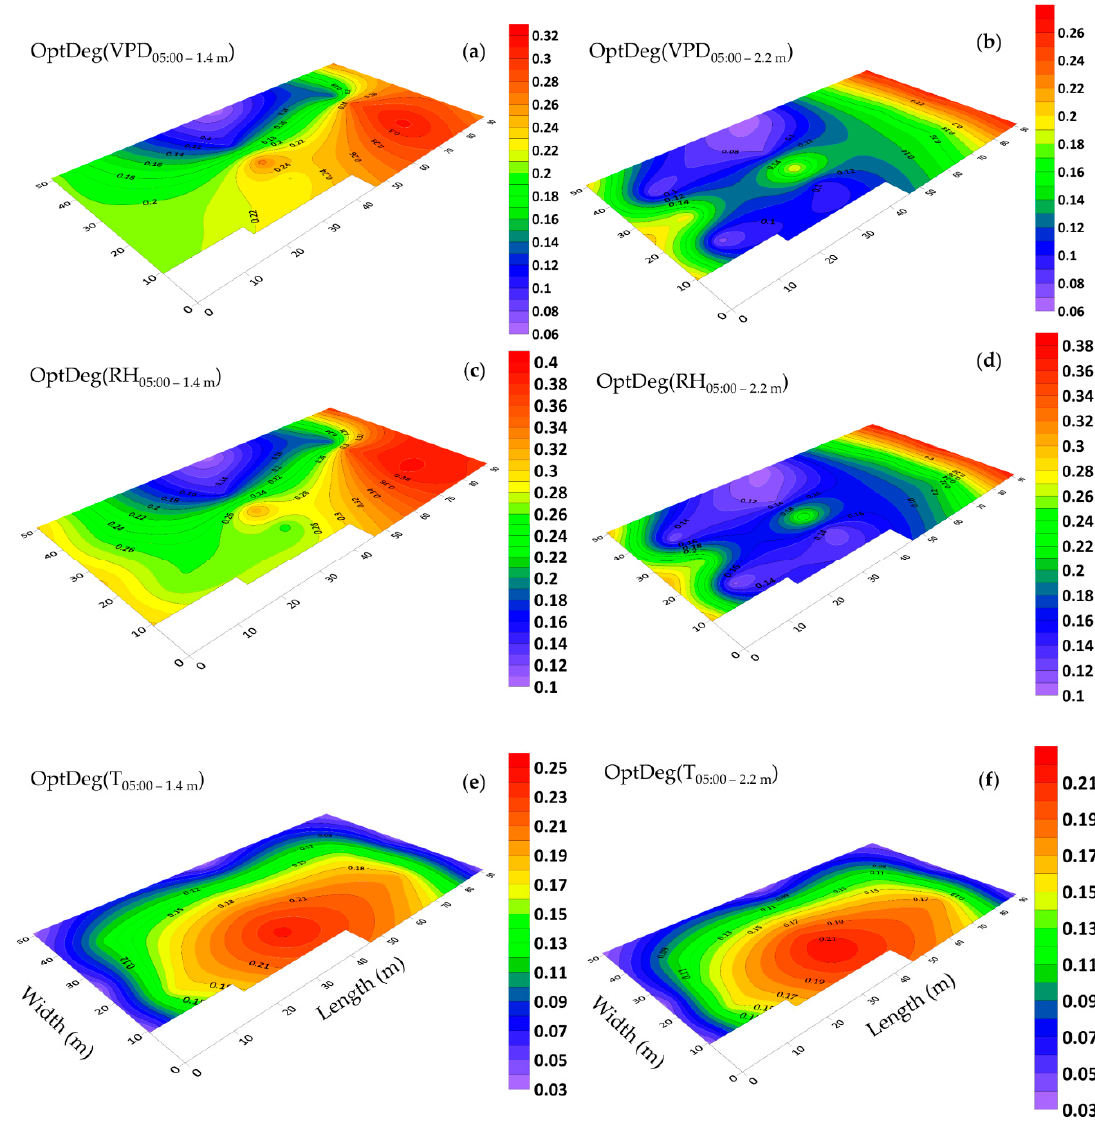
Figure 15. Optimality degrees range and distribution on a horizontal plane at 05:00 in 1.4 m and 2.2 m elevations on 10 June 2018. OptDeg(VPD) at 1.4 m ( a ) and 2.2 m ( b ); OptDeg(RH) at 1.4 m ( c ) and 2.2 m ( d ); and, OptDeg(T) at 1.4 m ( e ) and 2.2 m ( f ). At 16:00, the sides and back (north) walls, vents of the greenhouse were open and the exhaust fans were on. Temperature optimality degree distribution indicated critical temperature conditions in the greenhouse (Figure